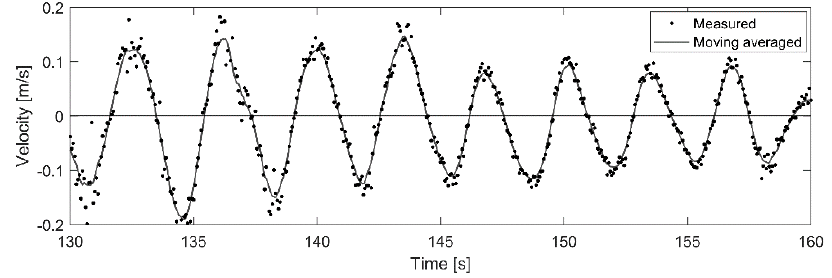
Figure 3. Raw and smoothed velocity time series for a typical 30 ‐ s interval.